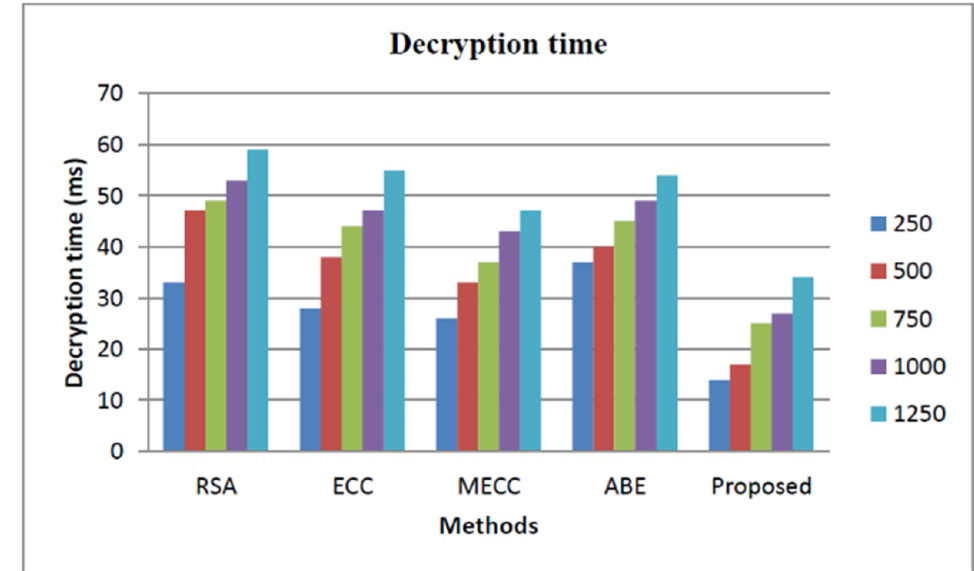
Figure 6. Storage security analysis based on decryption time.